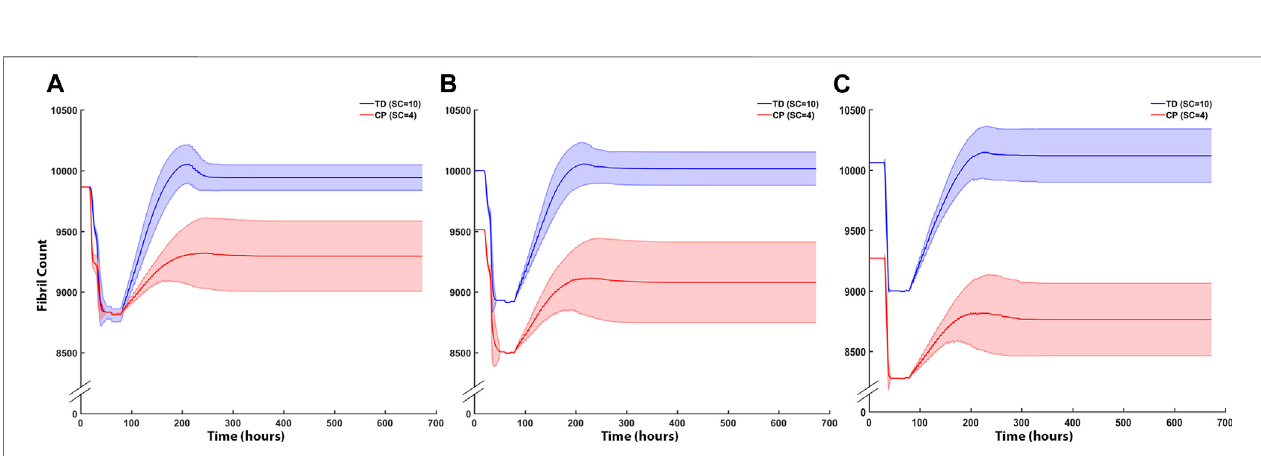
FIGURE8| ABMcellcountsovertime(mean ± SD)seededwithCP(SC (cid:2) 4)orTD(SC (cid:2) 10)initialconditions. (A) Iterationonecellcountsoverthe fi rst672 h,based on initial geometry. TD fi bril count exceeded initial count whereas CP fi bril recovery was impaired. (B) ABM cell counts (mean ± SD) using TD and CP iteration two geometry and strain values seeded with CP (SC (cid:2) 4) or TD (SC (cid:2) 10) conditions. TD fi bril recovery continued to exceed initial counts and CP fi bril recovery was further impaired. (C) IterationthreeoftheABMcellcounts.TD fi bril countpeaked abovetheoriginalvalueduringrepair however stabilised tojustbelowinitialvaluesbythe end of the simulation. CP fi bril recovery decreased to 8,763 ± 315 (mean ±